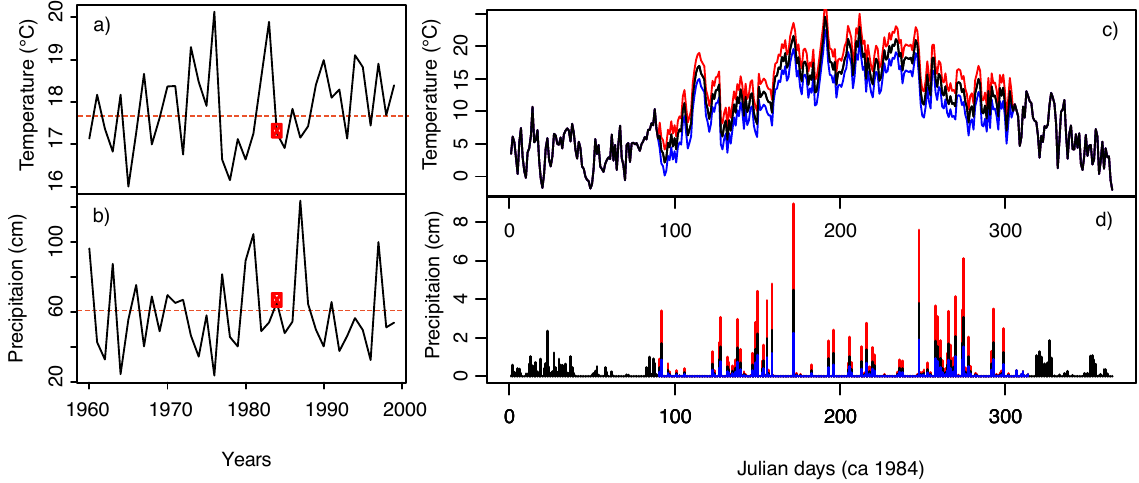
Figure 2. Yearly and daily (1984) summer temperature and precipitation series for the Fontainebleau Forest. The left panel presents temper- ature (a) and precipitation (b) series, with the AMY (1984) indicated by red squares. Average conditions are in dashed red. The right panel presents daily variations (in 1984) for temperature (c) and precipitation (d) . Black curves represent observations in 1984 (AMY). The red curve corresponds to the AMS that results from the modification of the AMY by a δ τ of 2 and a δ π of 2. The blue curve represents an AMS that originates from the modification of the AMY by a δ τ of − 2 and a δ π of